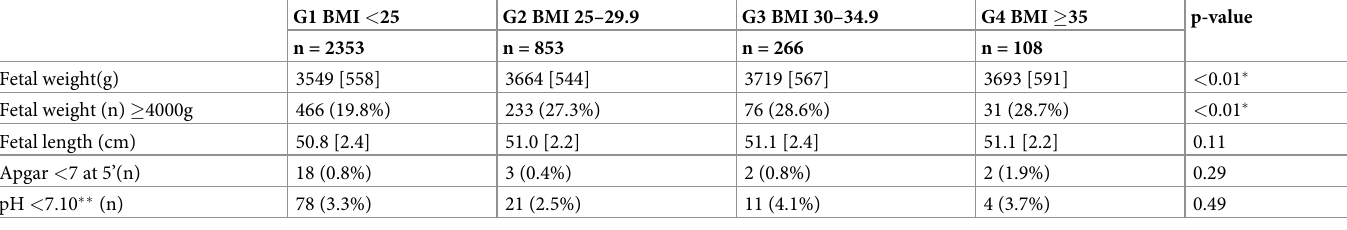
Table 3. Fetal outcome presented by BMI group (G1-G4). Data are presented as numbers (%) or mean (standard deviation [SD]). P-values < 0.05 were considered statis- tically significant �